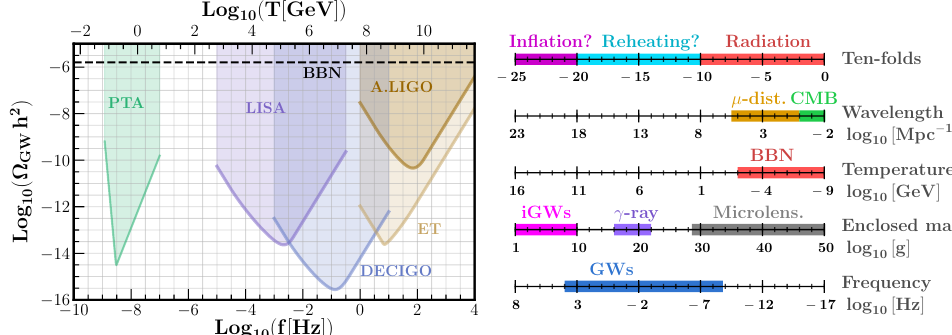
Figure 1. On the left we show the power-law integrated sensitivity curves [28] in terms of the GW spectral density for some GW detectors. In the lower and upper horizontal axis, we respectively show the GW frequency and the associated temperature of the universe at the time of GW generation, assuming radiation domination. On the right, we show the typical quantities associated to the cosmological horizon at a particular time, given in terms of 10-folds from matter-radiation equality. We also show the ranges covered by CMB anisotropies and µ spectral distortions, BBN constraints